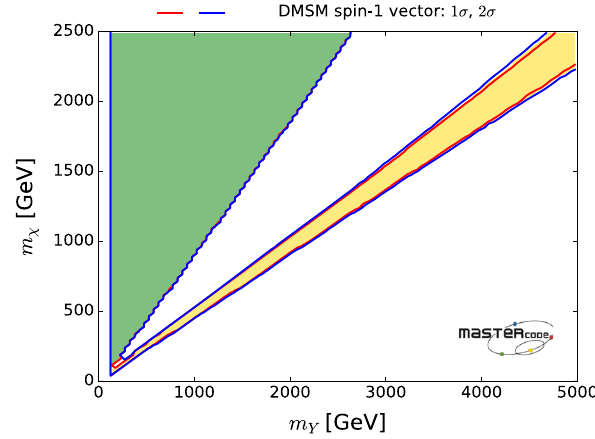
Fig. 4 Preferred regions in the ( m Y , m χ ) plane in the vector-like model. We delineate with red (blue) contours, respectively, the param- eter regions with (cid:9)χ 2 < 2 . 30 ( 5 . 99 ) , which are favoured at the 68% (95%) CL and regarded as proxies for 1- (2-) σ regions, respectively. We also use colour coding to illustrate the dominant mechanisms bringing the DM density into the allowed range: green for annihilation via t - channel exchange into pairs of mediator particles Y that subsequently decay into SM particles, and yellow for rapid annihilation directly into SM particles via the s -channel Y